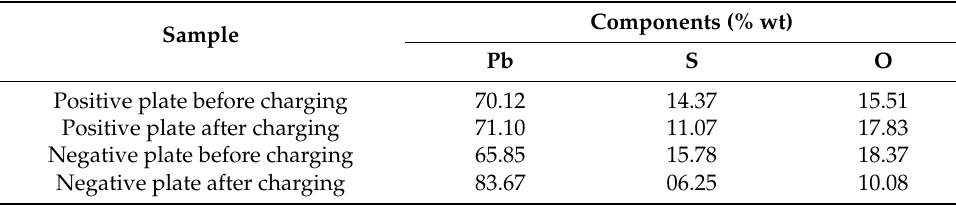
Table 8. EDX analysis of positive and negative plates before and after charging.